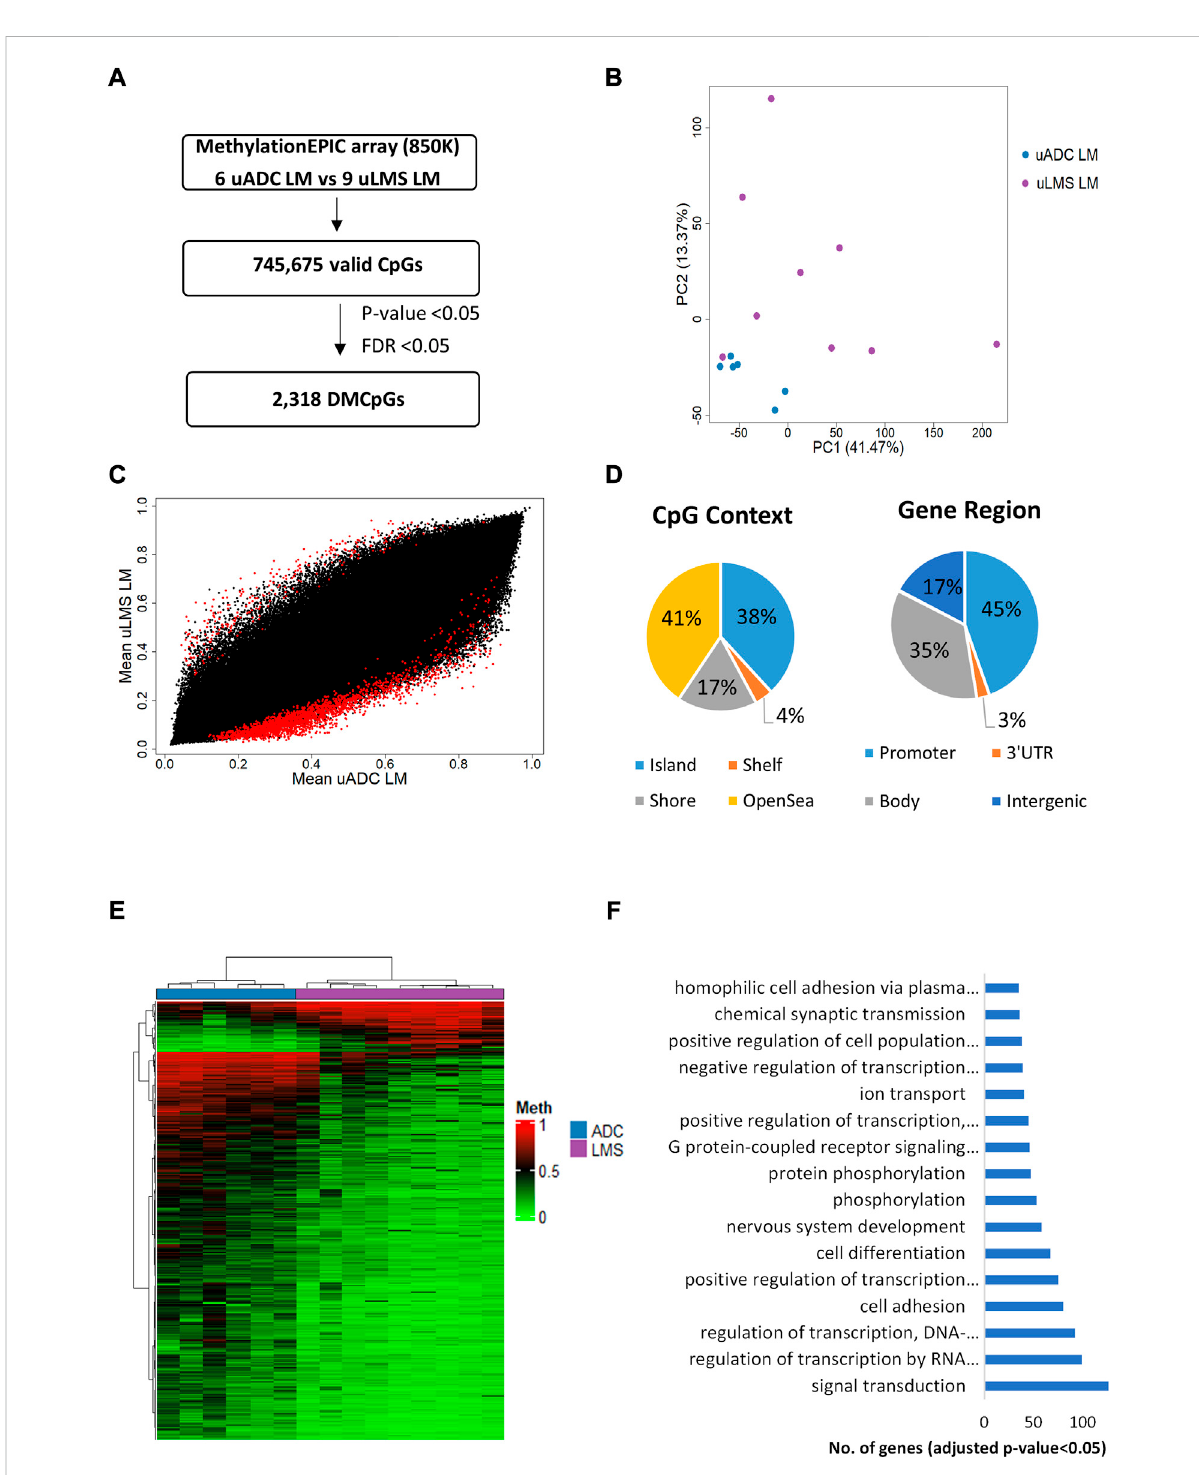
FIGURE 8 Genome-wide DNA methylation analysis of the ITF between metastatic tumors. (A) Schematic fl owchart followed to obtain signi fi cant differentially methylated CpGs at the ITF. (B) Principal component analysis (PCA) of DNA methylation data at the ITF. (C) Scatter plot representing mean normalized levels of DNA methylation ( β -values) at the ITF. Dots in red show signi fi cant differentially methylated CpGs. (D) Genomic distribution of the 2,318 signi fi cant differentially methylated CpGs in ITF by CpG context and gene region. (E) Hierarchical clustering of the 2,318 differentially methylated CpGs (FDR < 5%) in the ITF of LM-uADC and LM-uLMS patients. (F) Gene ontology (GO) analysis of the biological processcategoriesforthe2,318differentiallymethylatedCpGsattheITFofLM-uADCandLM-uLMS.DMCpGs,differentiallymethylatedCpGs;Meth, DNA methylation; LM, lung metastasis; uADC, uterine adenocarcinomas; uLMS, uterine